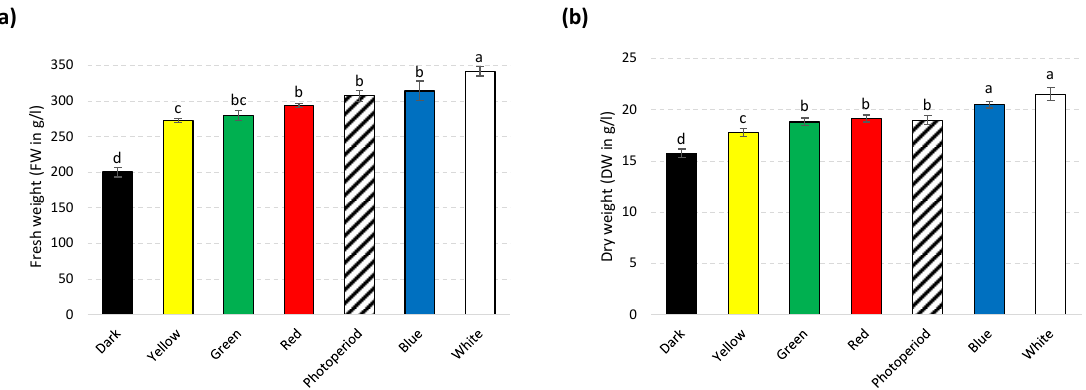
Figure 2. ( a ) Fresh weight (FW g / L) accumulation and ( b ) dry biomass (DW g / L) accumulation in callus cultures of S. xanthocarpum grown under di ff erent monochromatic lights conditions after 35 days of cultivation. Data are expressed as mean ± SD of at least three independent experiments. Di ff erent letters indicate significant di ff erences between conditions ( p < 0.05).